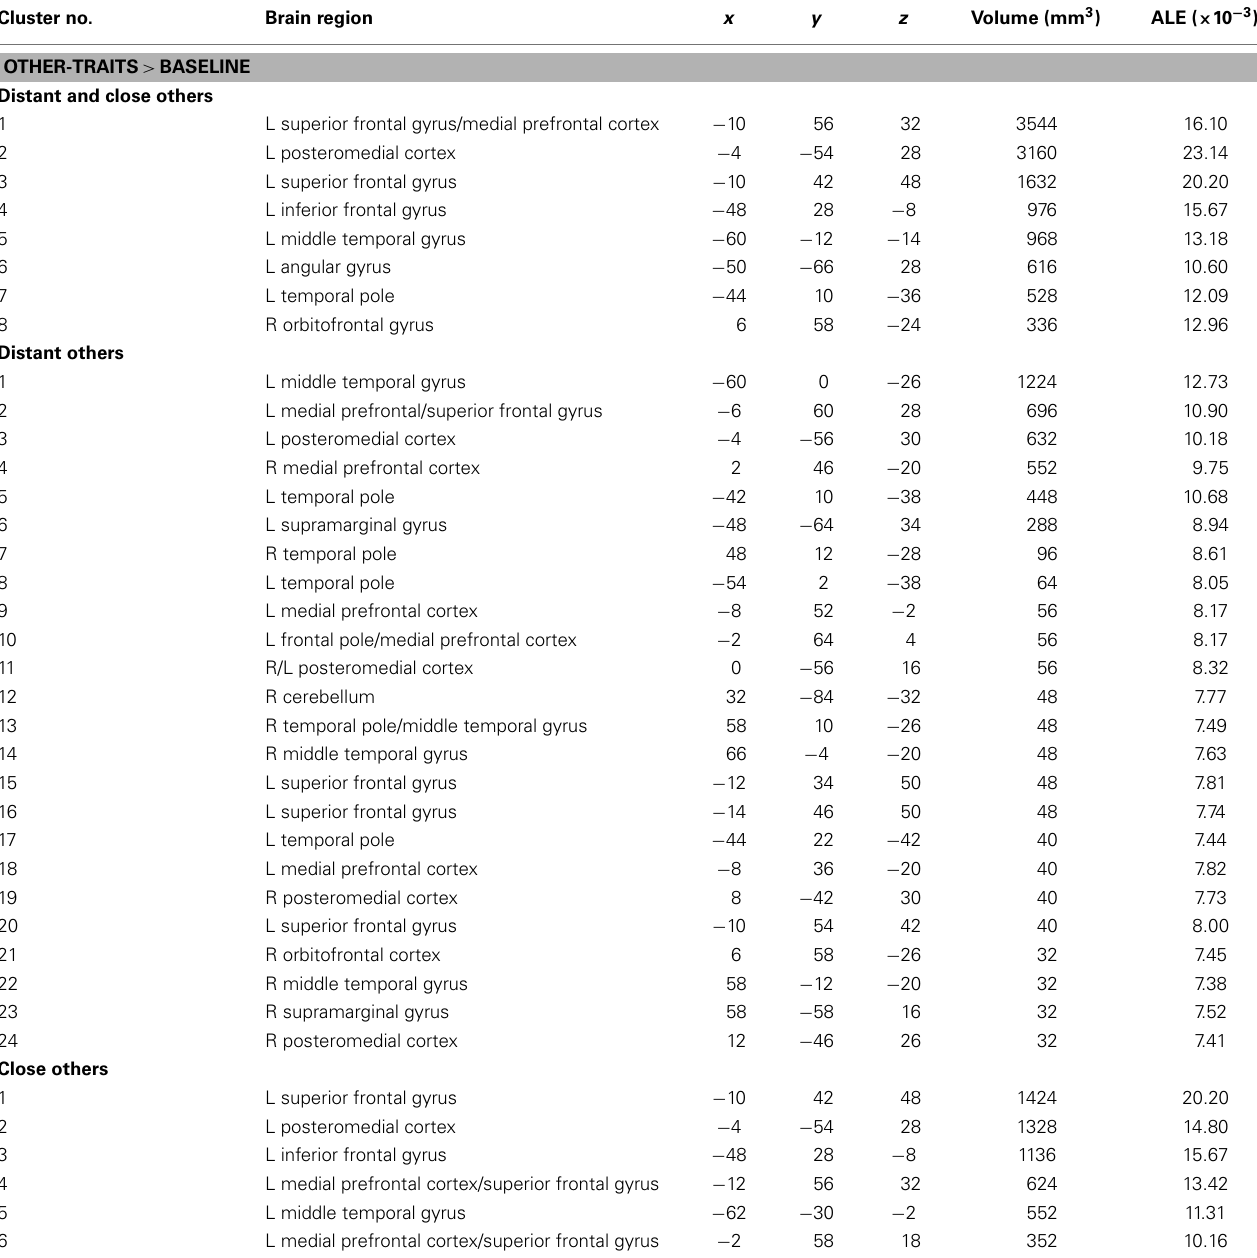
Table 3 | Meta-analysis of activation foci for other-traits compared with baseline in relation to both kinds of other (114 foci; 12 experiments), to distant others (46 foci; 6 experiments), and to close others (68 foci; 9 experiments). Cluster